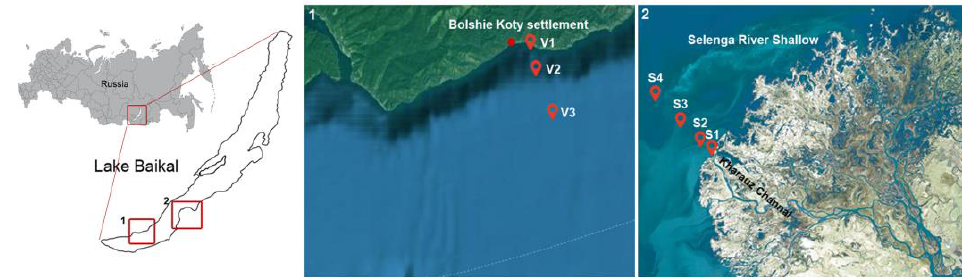
Figure 1. Sampling sites near the village of Bolshiye Koty, Varnachka area (V1, V2 and V3), and in the area where the Selenga River flows into the lake (Kharauz Channel) (S1, S2, S3 and S4).